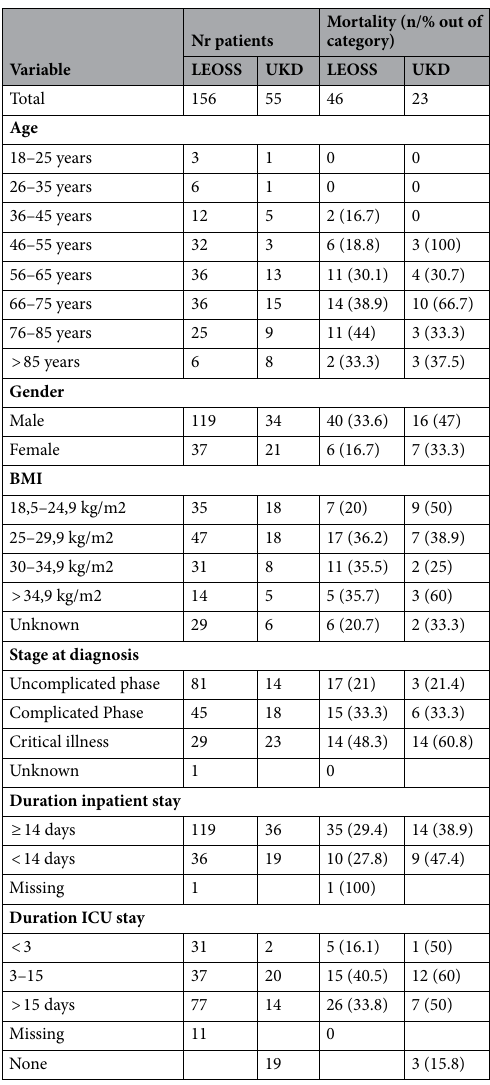
Table 1. Characteristics of LEOSS and UKD patients with CP